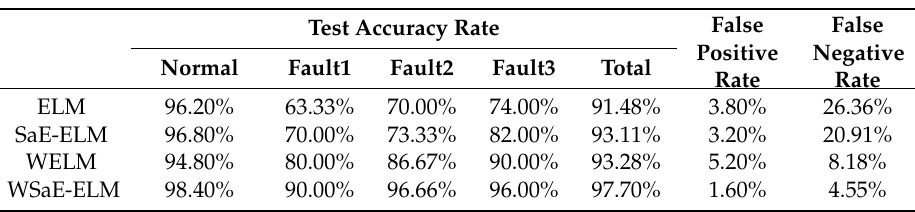
Table 5. Results of bogie fault diagnosis.